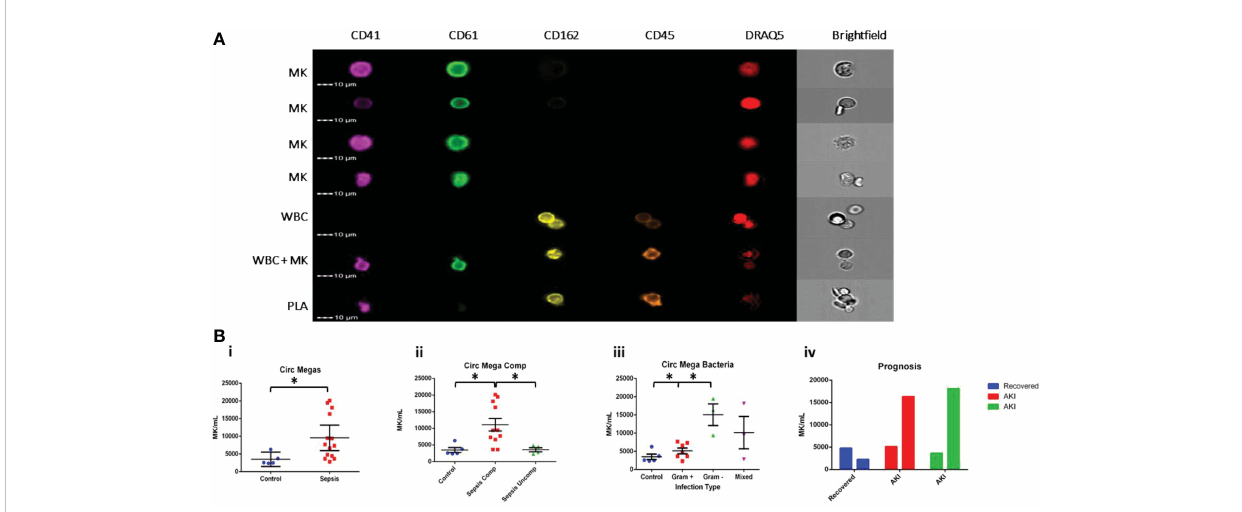
FIGURE 2 MKs are increased in the circulation during sepsis. Samples from patients diagnosed with sepsis were evaluated for the presence of possible MKs. MKs were identi fi ed in the peripheral circulation based on the simultaneous expression of CD41, CD61, and DRAQ5. (A) Imaging fl ow cytometry was used to identify and quantify circulating CD41+CD61+Draq5+ cells in the peripheral circulation. CD45 and CD162 were used as white blood cell markers. The top 4 panels show examples of MKs, while the bottom three panels show examples of two white blood cells, a white blood cell attached to a MK, and a white blood cell attached to a platelet (PLA). The cells negative for all markers in the images are likely red blood cells. (B) Circulating MKs were signi fi cantly higher in the peripheral circulation in patients with sepsis (i). The amount of MKs was correlated with sepsis- related complications, including ARDS and AKI, with ‘ complicated ’ sepsis having signi fi cantly higher MKs than ‘ uncomplicated ’ sepsis (ii). MKs were higher in gram negative and mixed infections compared to gram positive only infections (iii). Bar chart representing the MK count in 3 patients with sepsis that had blood collected on >1 day during the study. One patient recovered (blue) and two patients (red and green) developed AKI by day 3 of sample collection, suggesting that there also may be a correlation with recovery and the development of sepsis complications, such as AKI (iv). Statistics: student t-test (Bi) and ANOVA (Bii, iii) we performed, with signi fi cance de fi ned as p < 0.05 (*). No statistical analysis was performed on the data in panel Biv due to the small sample size (n = 1 per